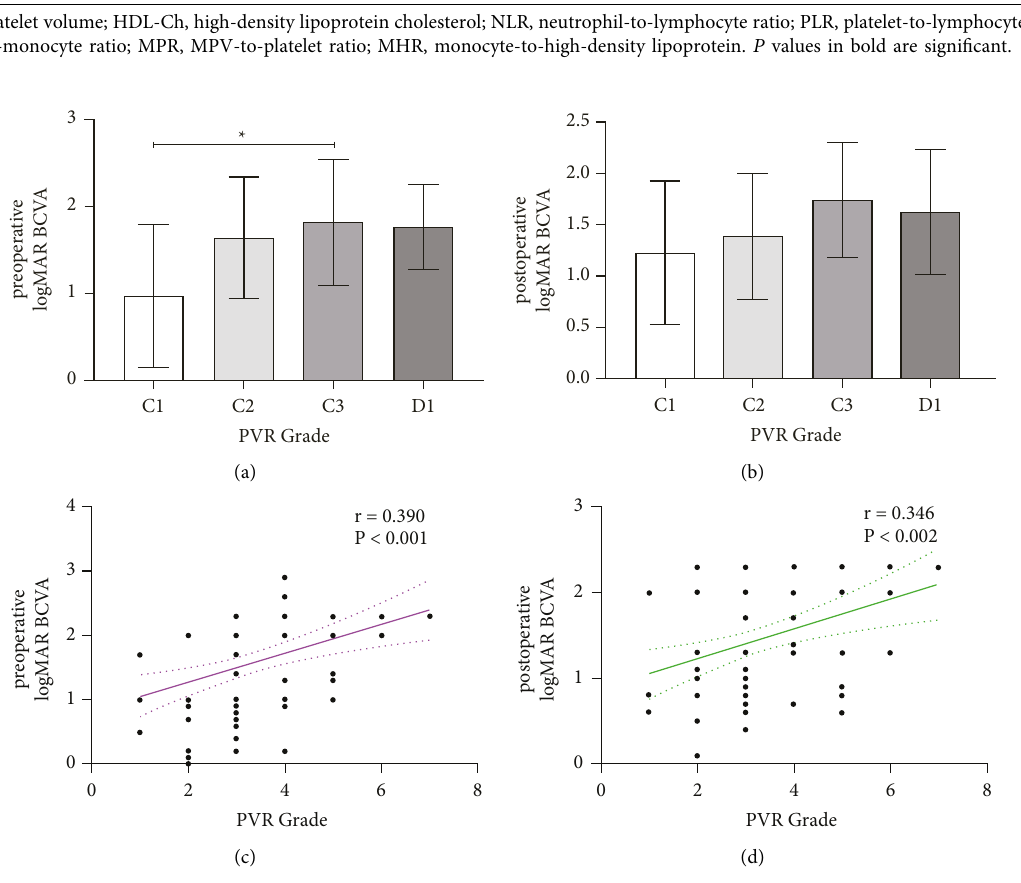
Figure 1: (a) Comparison of preoperative logMAR BCVA between grade C1, C2, C3, and D1 in RRD patients was statistically significant ( P � 0 . 023). (b) Comparison of postoperative logMAR BCVA between grade C1, C2, C3, and D1 in RRD patients was not statistically significant ( P � 0 . 145). (c) Correlation between preoperative logMAR BCVA and PVR grade in RRD patients ( P < 0 . 001, r � 0.390). (d) Correlation between postoperative logMAR BCVA and PVR grade in RRD patients ( P � 0 . 002, r � 0.346). Abbreviations: logMAR, logarithm of the minimum angle of resolution; BCVA, best-corrected visual acuity; RRD, rhegmatogenous retinal detachment; PVR, proliferative